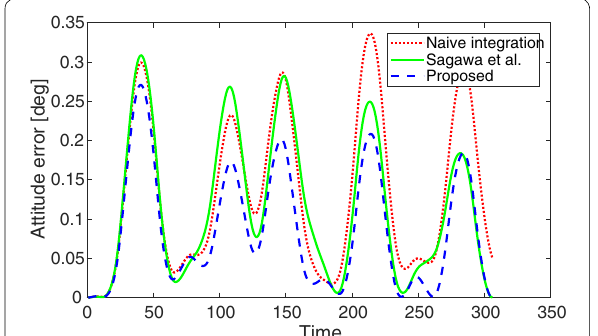
Fig. 4 Attitude estimation errors for comparison